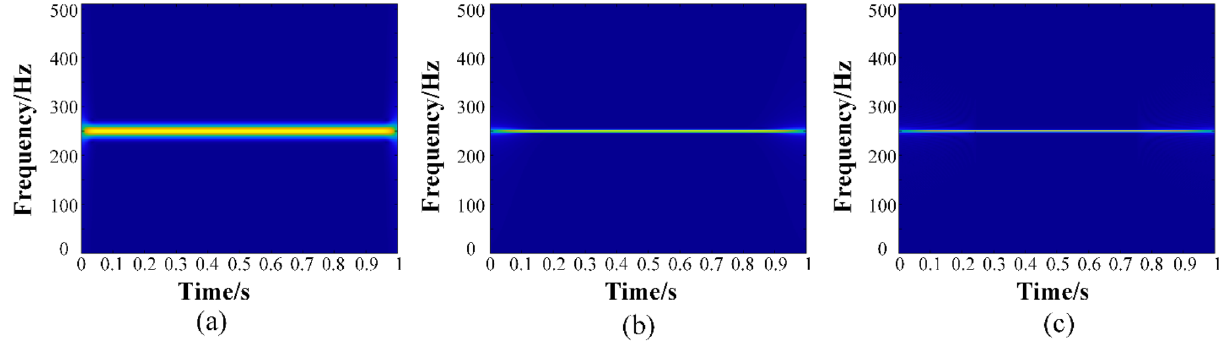
Figure 1. TFR results calculated by using ( a ) STFT, ( b ) GWT, ( c )